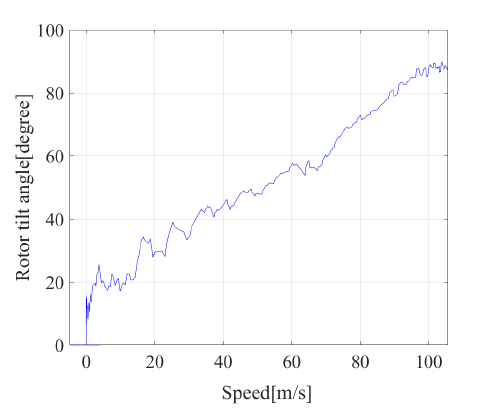
Fig. 15. Curve of transition corridor of this algorithm under wind disturbance.